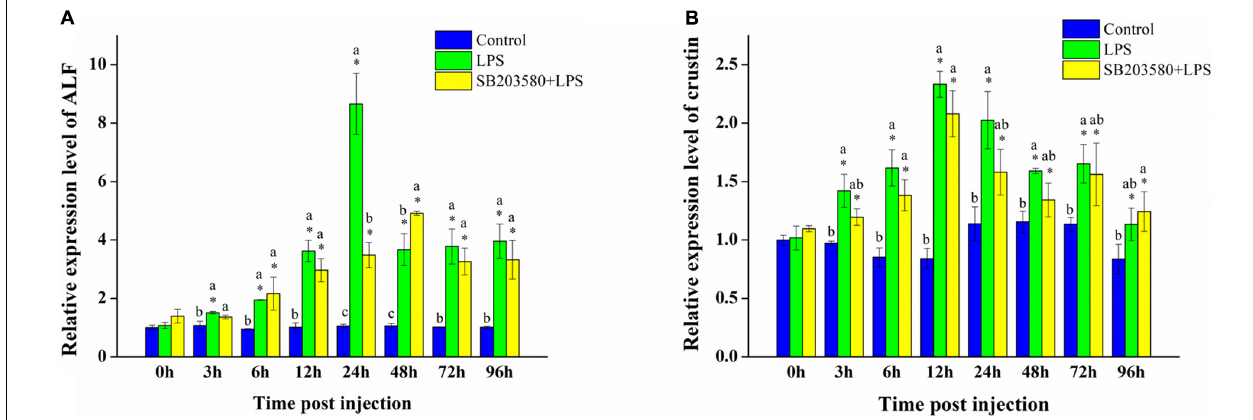
FIGURE 7 | Analysis of the ALF and crustin gene expression in the hepatopancreas under LPS stimulation. (A) Analysis of the ALF gene expression in the hepatopancreas under LPS stimulation. (B) Analysis of the crustin gene expression in the hepatopancreas under LPS stimulation. Using GAPDH as an internal reference, the relative expression level of ALF in the control group at 0 h was set to 1. Error bars represent the SD of three independent repeats, and the results are expressed as means ± standard deviation. Independent sample t -test analyzed the significant changes at different time points in the same treatment group. *Indicates a significant difference between this time point with 0 h. Duncan’s multiple comparison test analyzed the significant changes between different treatments at the same time point. a, b, and c indicate significant differences between treatment groups. P < 0.05 was considered statistically